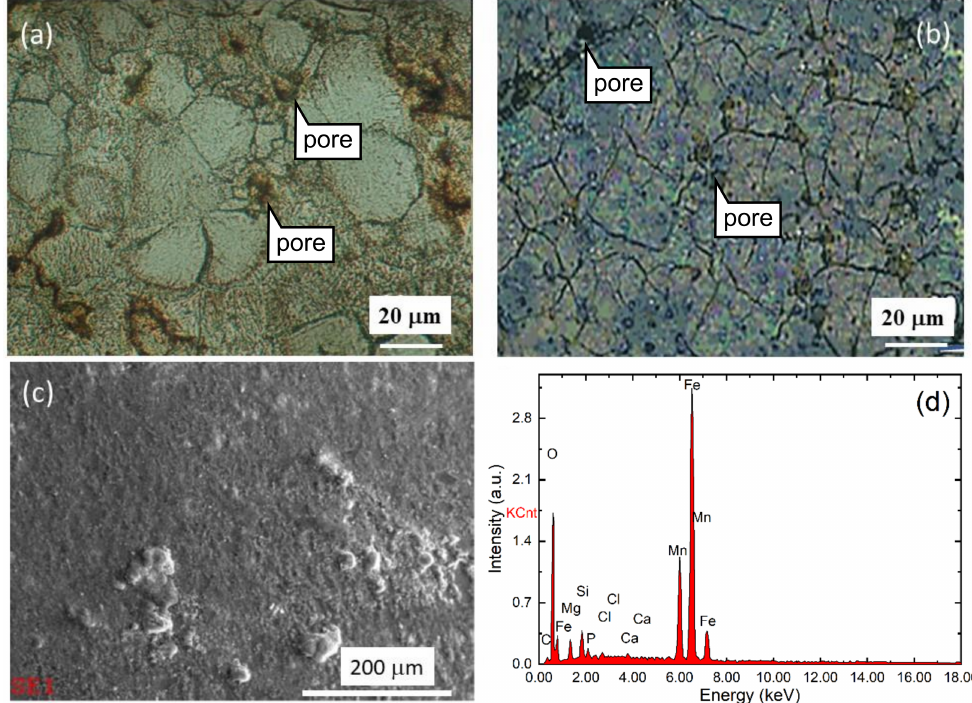
Figure 1. Micrographs of non-BM Fe25Mn1C sample ( a ) and BM Fe25Mn1C sample ( b ), micro-morphology of BM Fe25Mn1C sample’s surface after 7 days immersion ( c ), and elemental analysis of BM Fe25Mn1 sample’s surface after 7 days immersion ( d